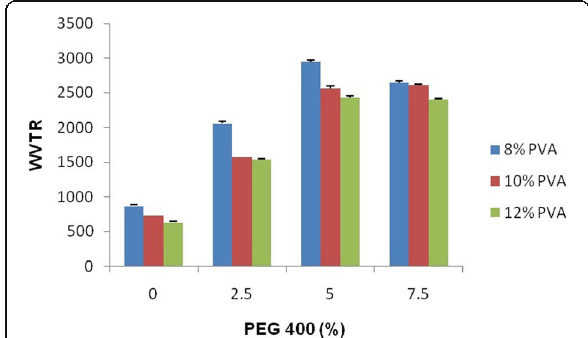
Fig. 5 Effect of concentration of PEG 400 and PVA on percentage WVTR of the hydrogel sheets, n = 3, mean ± SEM